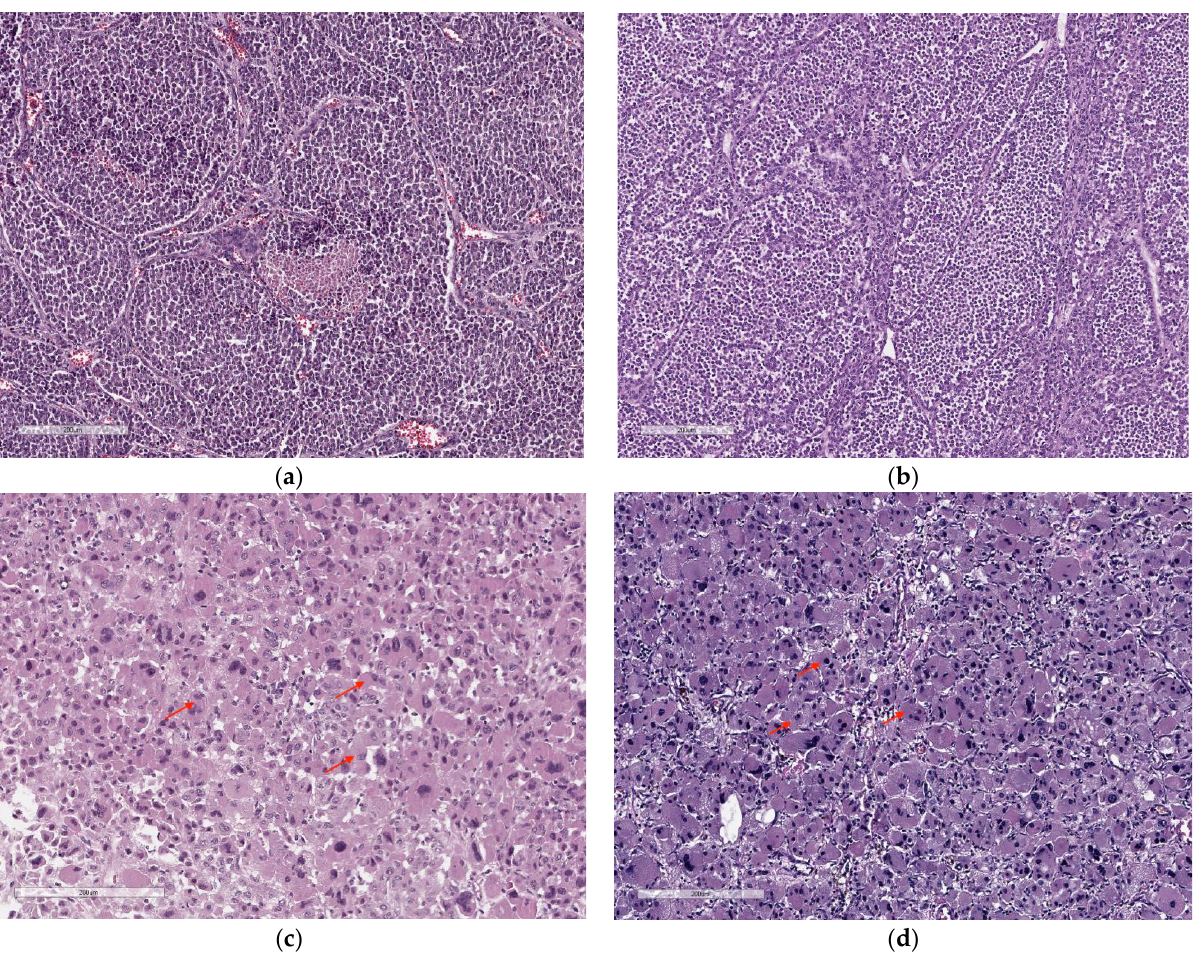
Figure 1. Hematoxylin and eosin staining of samples of conventional ( a , b ) and oncocytic ( c , d ) histological variants of ACC. Red arrows indicate the representative oncocytic cytology characterized by an abandoned granular eosinophilic cytoplasm.